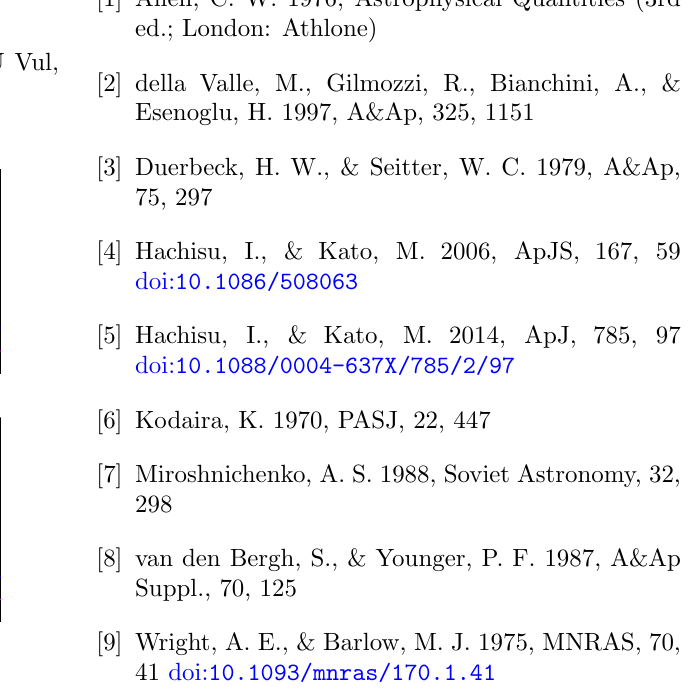
Figure 7: (a) QV Vul, (b) V443 Sct, (c) V1419 Aql, and (d) V705 Cas.